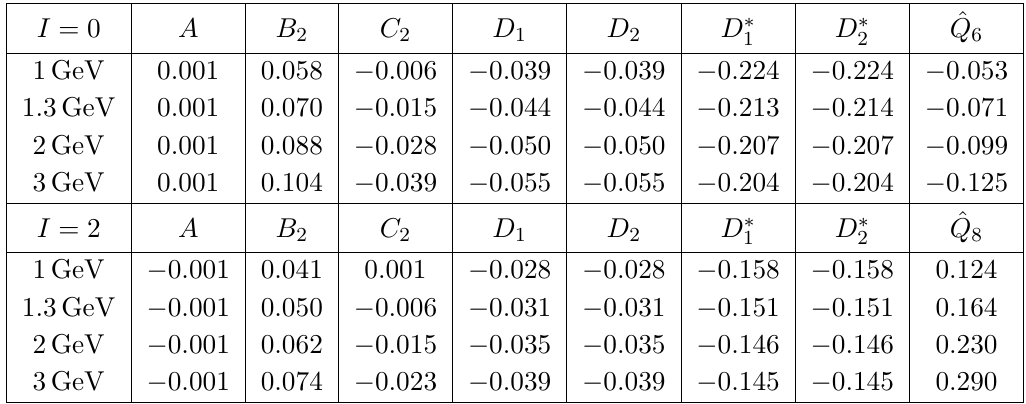
Table 2 . Matrix elements h X i i 0 ; 2 of BSM operators in the DQCD basis allowed by SMEFT contributing to the isospin amplitudes A 0 ; 2 in units of GeV 3 for four values of (cid:22) . In the last column we give the values of the matrix elements h ^ Q 6 ( (cid:22) ) i 0 and h ^ Q 8 ( (cid:22) ) i 2 for comparison.